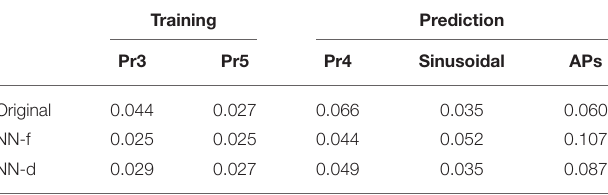
TABLE 2 | Mean absolute error of the model simulations for the CHO cell data. Training